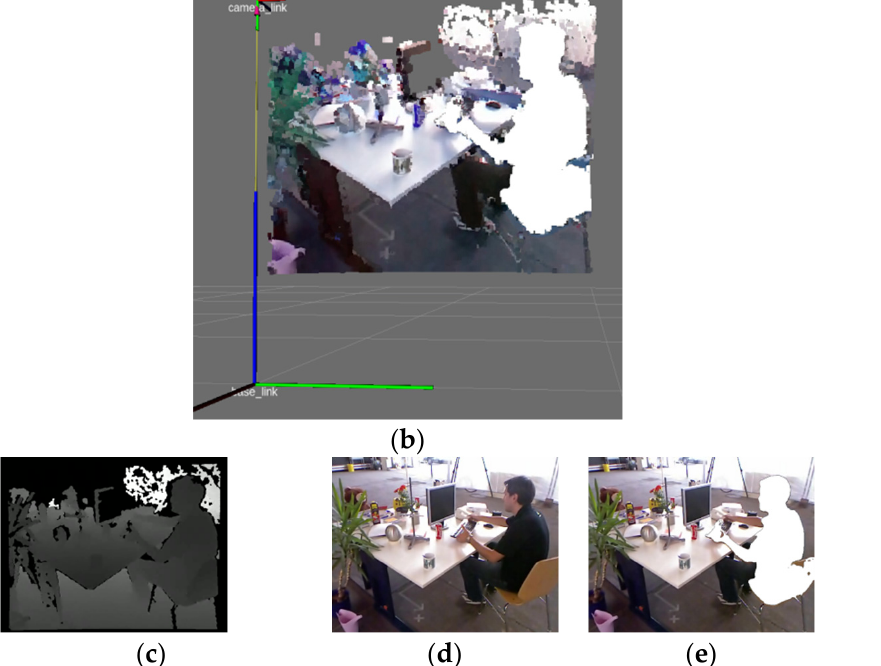
Figure 10. Point cloud images ( a , b ) are generated from RGB image ( d ) and segmented RGB image ( e ) combined with depth map ( c ), respectively.